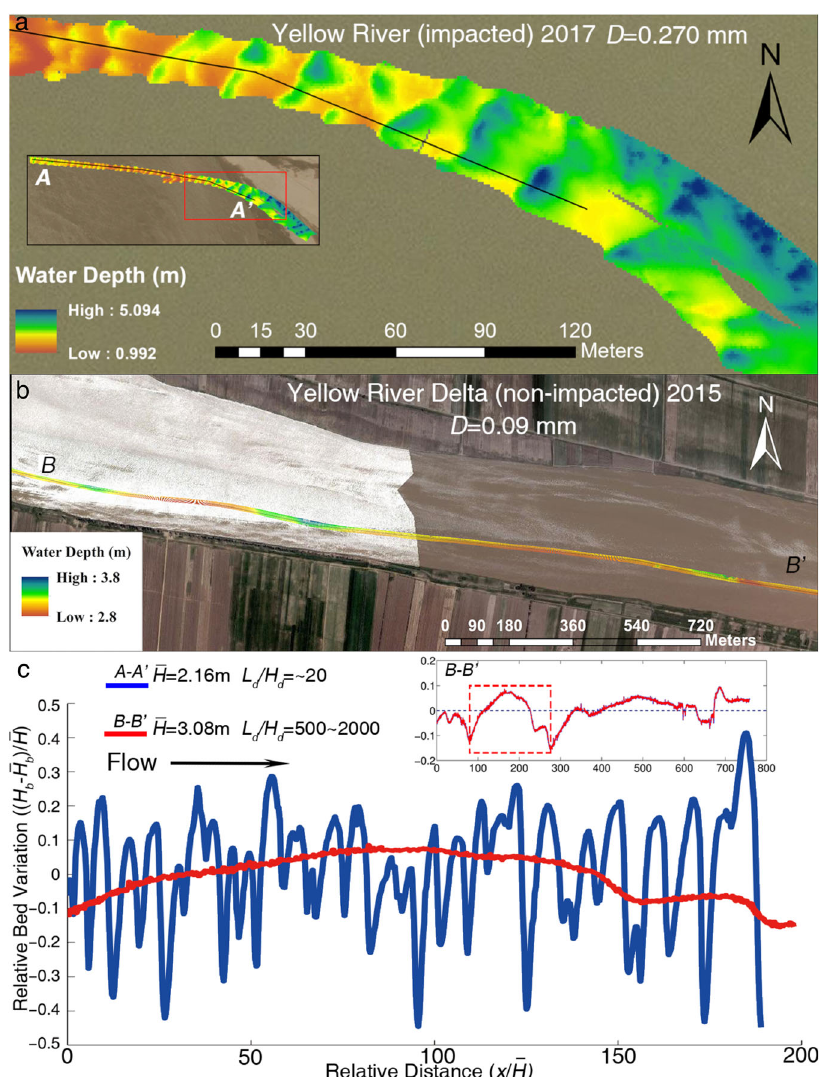
Fig. 3 Bedform geometry for the present-day Yellow River. a Multibeam echosounder (MBES) map of periodic, high-relief dunes ( L d / H d ~ 20 and H d = (cid:1) H ~ 40.81% ± 12.72%, where L d and H d are wavelength and wave height of bedforms [m], respectively and (cid:1) H is the average water depth [m]). These bedforms are found in abundance at Huayuankou, just downstream of Xiaolangdi Dam (see Supplementary Fig. S3 and Supplementary Table S3); b Low- relief bedforms ( L d / H d ~ 500 – 2000 and H d = (cid:1) H ~ 5.51% ± 3.26%) near Lijin, where bed sediment size is not impacted by the XLD dam; c Longitudinal pro fi les through the bedforms from the two studied reaches derived from the MBES maps. H b and (cid:1) H b represent the bed elevation along the transect and average bed elevation of the survey area, respectively. The fi ne-grained channel of the non-impacted downstream reach is characterized by low-relief bedforms, while the channel bed of the dam-impacted reach possesses high-relief dunes typical of sand-bedded rivers. The presence of low-relief bedforms is the primary reason for a lower fl ow If it is assumed that the relation H ( q w ) is unchanged (i.e., no than 20 years of cross-section data (1981 – 1990 for pre-dam and fl ood-stage ampli fi cation effect), then bed degradation would 2006 – 2015 for post-dam) were collected to assess stage change pre- and post-damming. Flood stages of each event were computed based on measured cross-sectional shape for each However, the fi eld data (blue) indicate that fl ood stage for the year, using the theoretical resistance relation (Text “ Hydraulic prediction for the fl ow stage based on observed cross-sections ” in Methods). The model has no adjustable parameters, nor are Q w or Z used to calibrate any parameter. Figure 5b shows theoretical predictions and observed data for different fl ood fl ow discharges (see Fig. S6 for a one-by-one comparison). The general trends of the Q w – Z relations are shown as pre-dam (red) and post-dam induced by dams, lowers fl ood stage by a slowly-varying value (blue). The post-dam Q w – Z relation without any effects of stage ampli fi cation produced by resistance enhancement is also with respect to water discharge (blue line in Fig. 5c), whereas indicated (pink). Cross-section variations are included via the enhanced resistance works as a multiplier (Eq. 1) to amplify fl ood fl ood-stage con fi dence intervals corresponding to fl ood discharge. stage (e.g., red line in Fig. 5c). Hence, as the net result of both